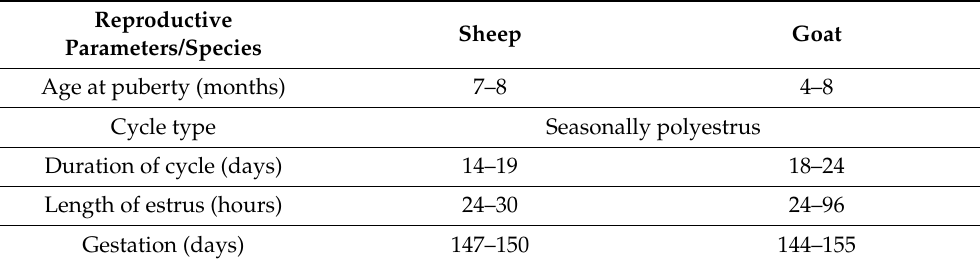
Table 3. Normal values of reproductive parameters in adults of Ovis aries (Sheep) and Capra aegagrus hircus (goat). (adapted from